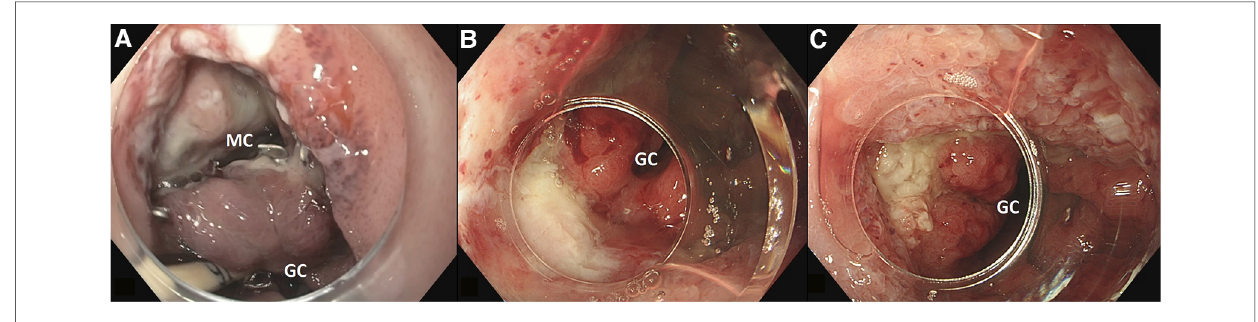
FIGURE 2 ( A ) large defect with mediastinal cavity (MC) due to anastomotic leakage after esophagectomy with gastric conduit (GC) reconstruction. ( B ) After fi rst VACStent. ( C ) After second